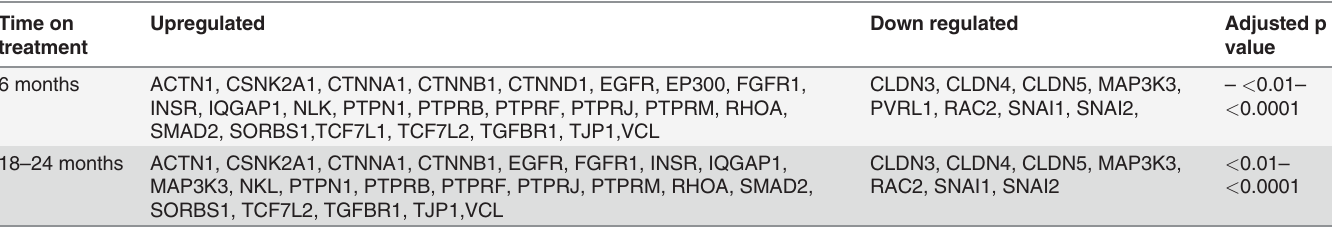
Table 3. Expression of genes controlling adherence junction in ABC treated group in comparison with controls at 6 months and 18 – 24 months after treatment.